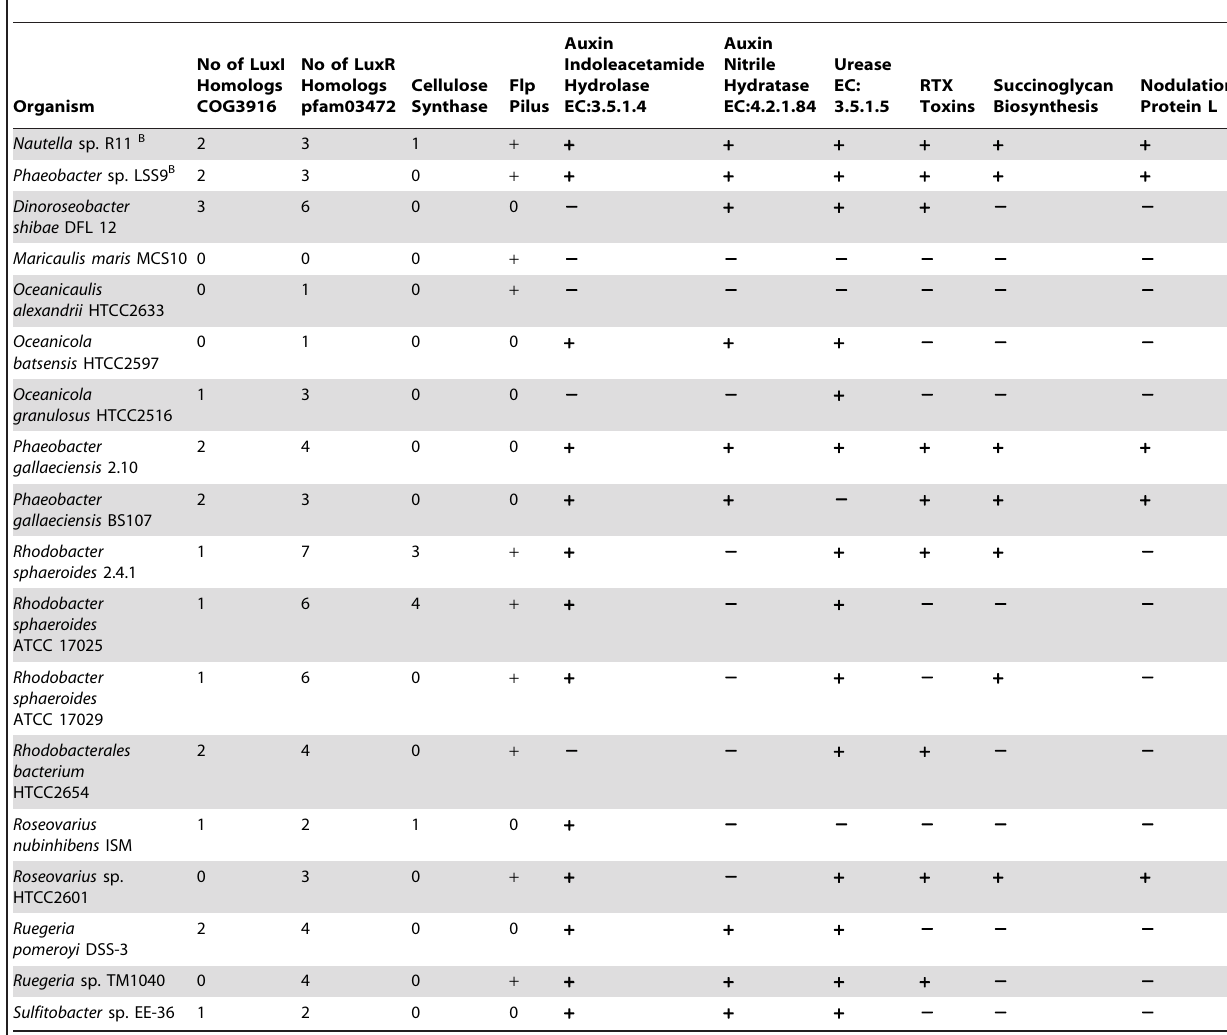
Table 3. Roseobacter genomes with AHL-driven quorum-sensing networks and other genes encoding putative virulence mechanisms ( B indicates strains with ability to cause